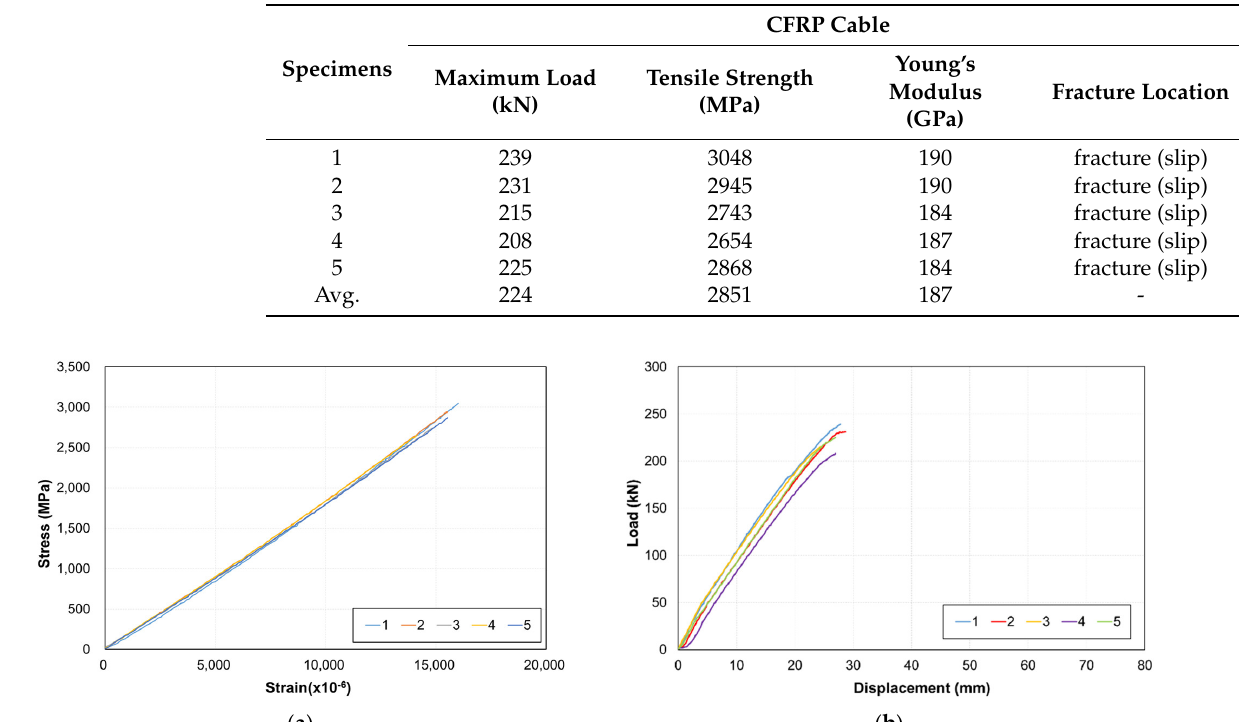
Figure 4. Fracture location image. Table 1. Tensile test results of the sample specimen. Table 1. Tensile test results of the sample specimen.